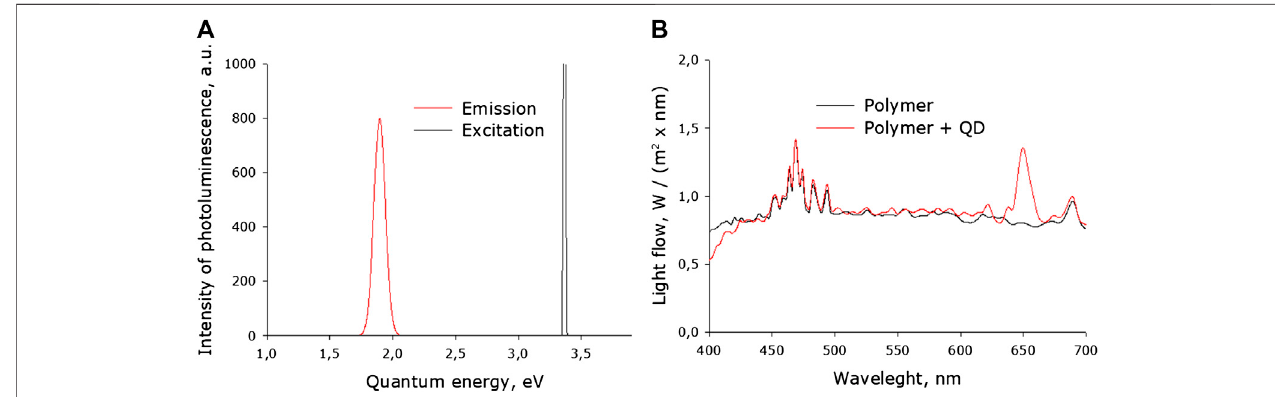
FIGURE2 | The photoluminescence spectrum of QD. (A) Photoluminescence spectrum ofphotoconversion nanoparticles in acetone. (B) The photoluminescence spectrumofa fl uoropolymer containingand not containingphotoconversion nanoparticles. Luminescence wasexcitedwith axenonlamp and adiode source (375